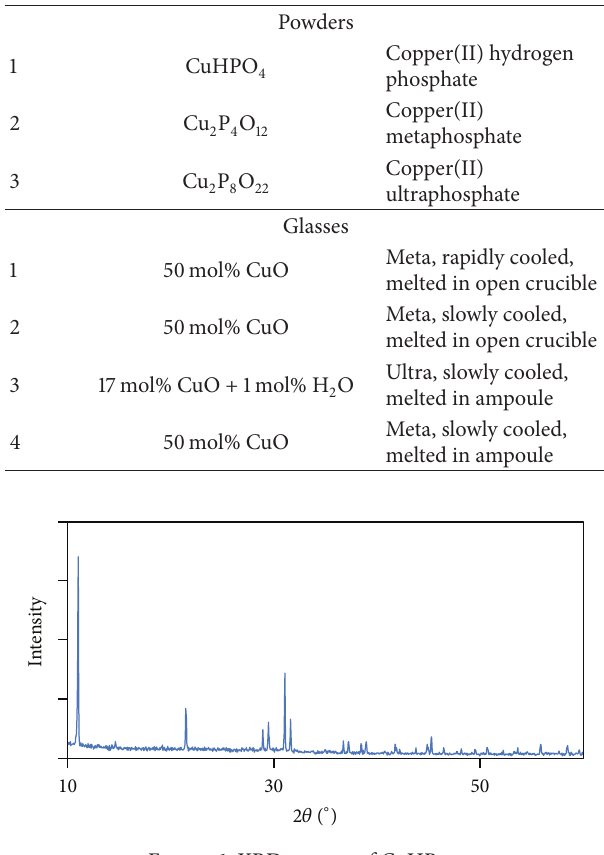
Table 1: List of investigated samples.